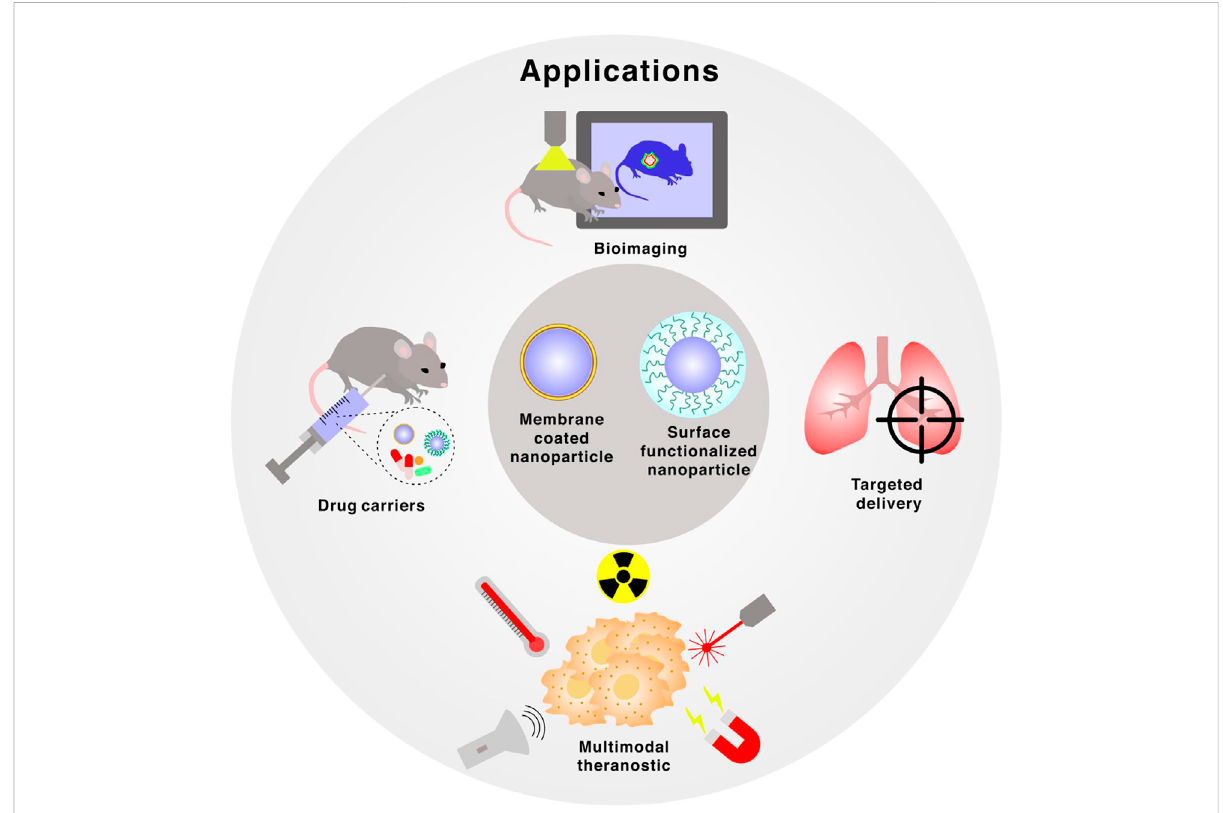
FIGURE 2 Applications of membrane-coated and surface functionalized nanoparticles, which includes bioimaging, targeted delivery, multimodal theranostic and drug